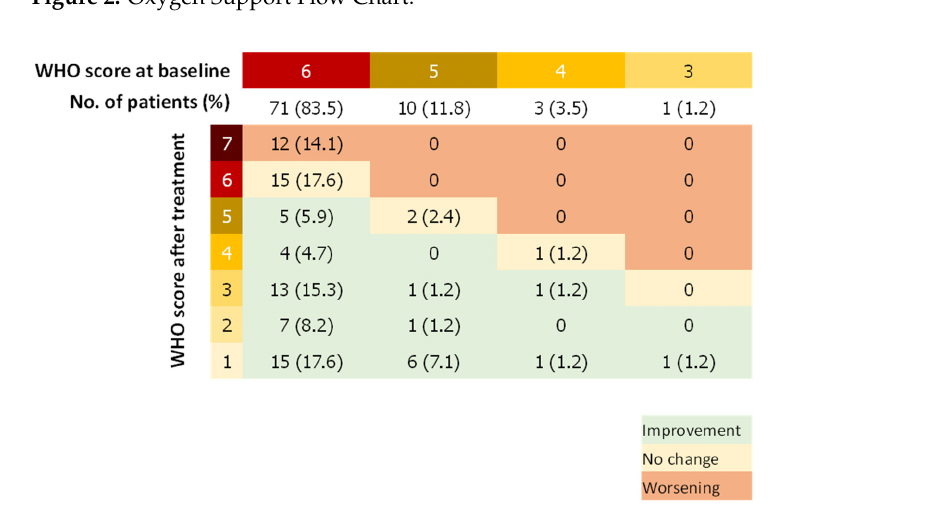
Figure 3. WHO Score Double-Entry Board. WHO score at baseline and after remdesivir treatment; Number (%).